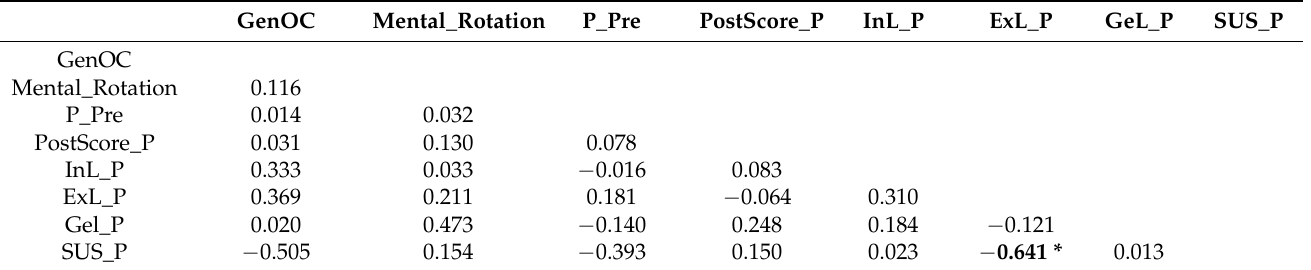
Table 8. Correlations for group two (AR) for the topic pericyclic reactions.